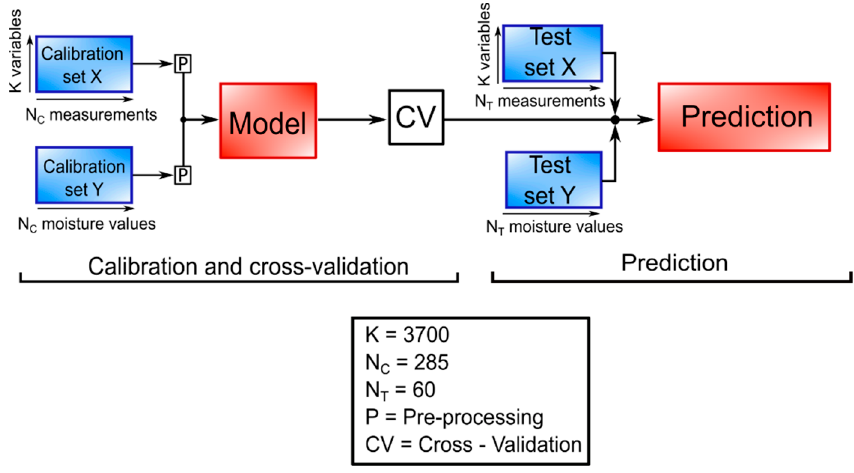
Figure 4. PLSR scheme.